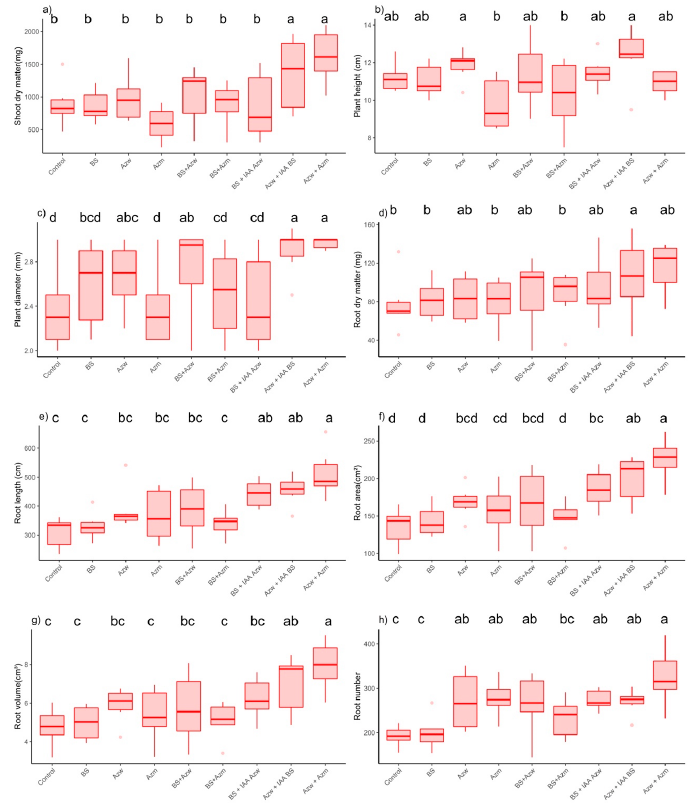
Figure 4. Boxplots of the Entire tomato plant growth evaluations inoculated with auxin-synthesizing bacteria. ( a ) shoot dry mass, ( b ) plant height, ( c ) plant diameter, ( d ) root dry matter, ( e ) root length, ( f ) root area, ( g ) root volume, ( h ) number of roots. Means followed by the same lowercase letter or absence of letters do not differ by Tukey’s test ( p < 0.05). Control, without inoculation; BS, B. subtilis; Azw, A. brasilense wild; Azm, A. brasilense mutant; BS + Azw, B. subtilis + A. brasilense wild; BS + Azm, B. subtilis + A. brasilense mutant; BS + IAA Azw, B. subtilis + exogenous auxin (400 µ g mL − 1 ); Azw + IAA BS, A. brasilense + exogenous auxin (30 µ g mL − 1 ); Azw + Azm, A. brasilense wild + A. brasilense